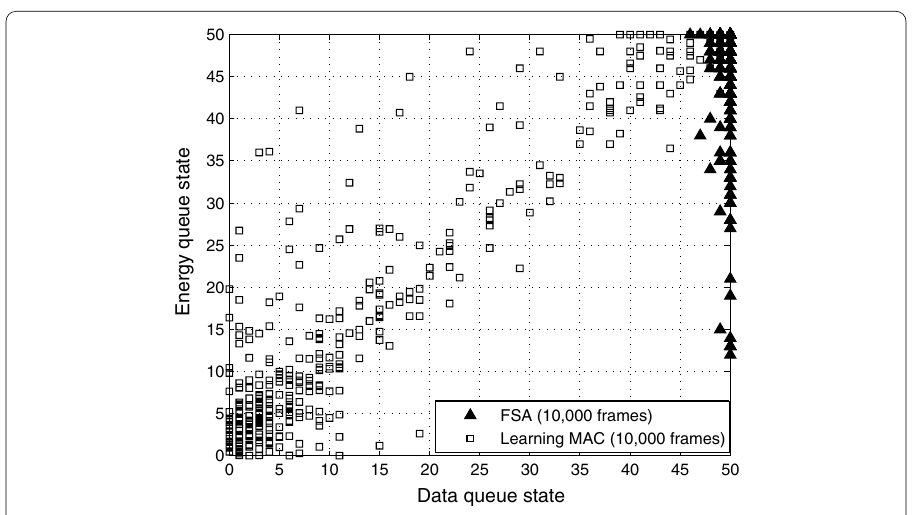
Fig. 5 Energy and data of queue states of the individual nodes ( N